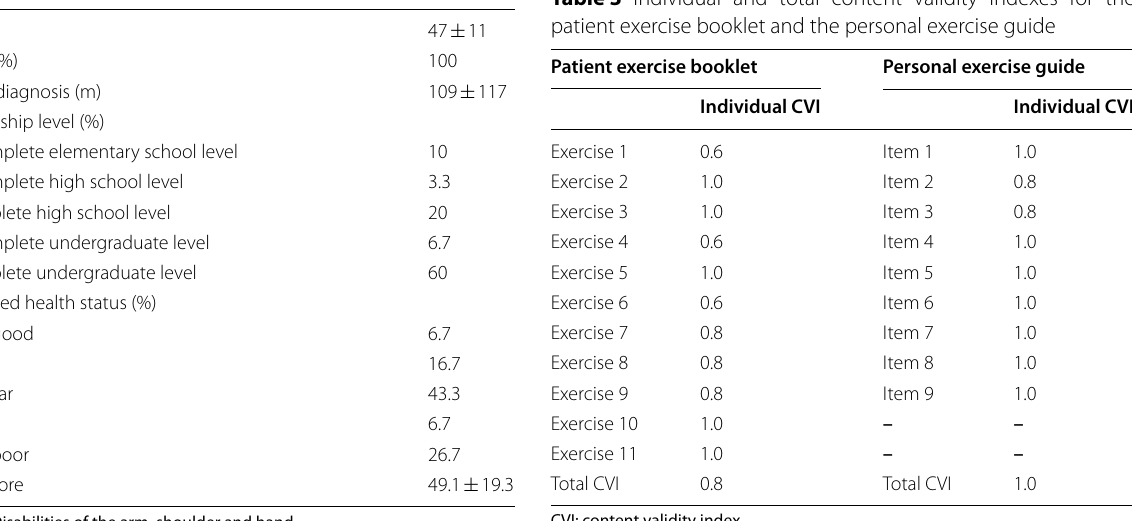
Table 3 Individual and total content validity indexes for